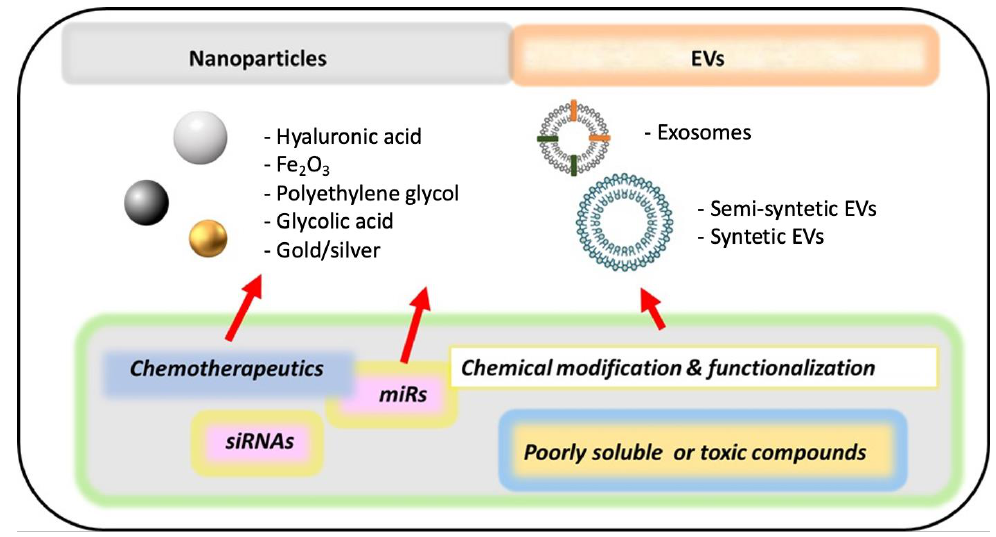
Figure 4. Some examples of advances in monotherapies and drug delivery for ovarian cancer. Most nanocarriers are under study in different models of ovarian cancer. It is expected that they could improve the delivery, half-life, and distribution of ovarian cancer therapies. Some examples of nanocarriers are nanoparticles, exosomes and modified extracellular vesicles (EVs). miRs: micro- RNAs. siRNAs: small interference RNAs.